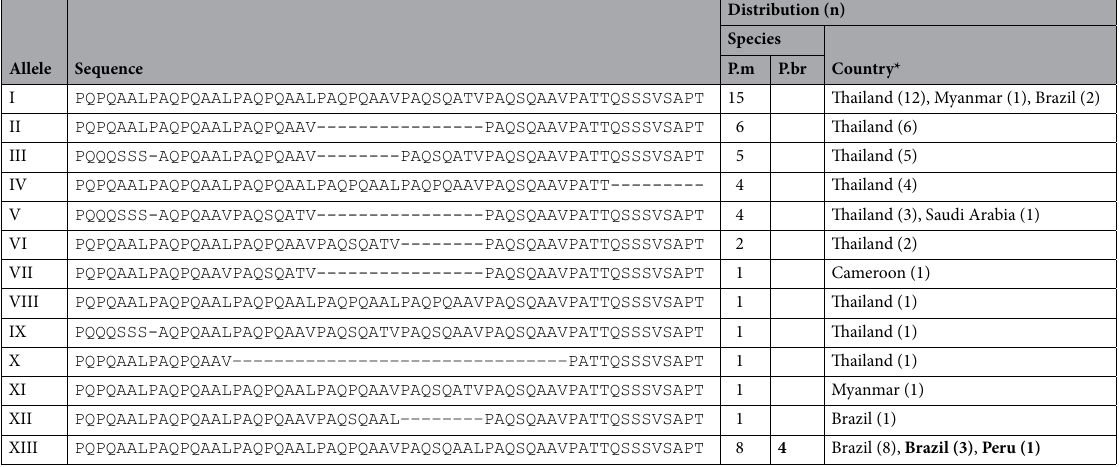
PQPQAALPAQPQAAVPAQSQATV----------------PAQSQAAVPATTQSSSVSAPT